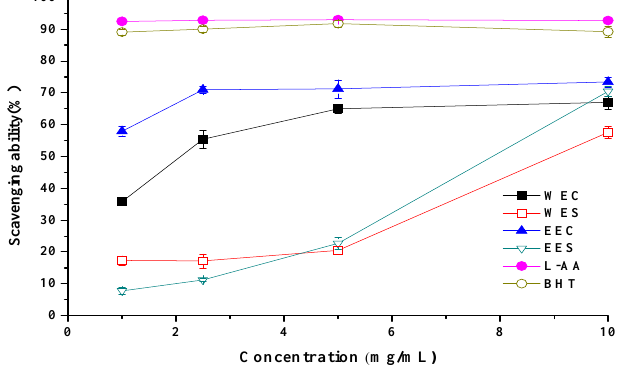
Each value is expressed as mean ± S.D. (n =